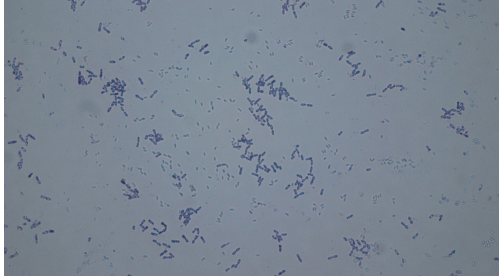
Figure 2. Bacillus pseudofirmus , Olympus BX41, 1000x.